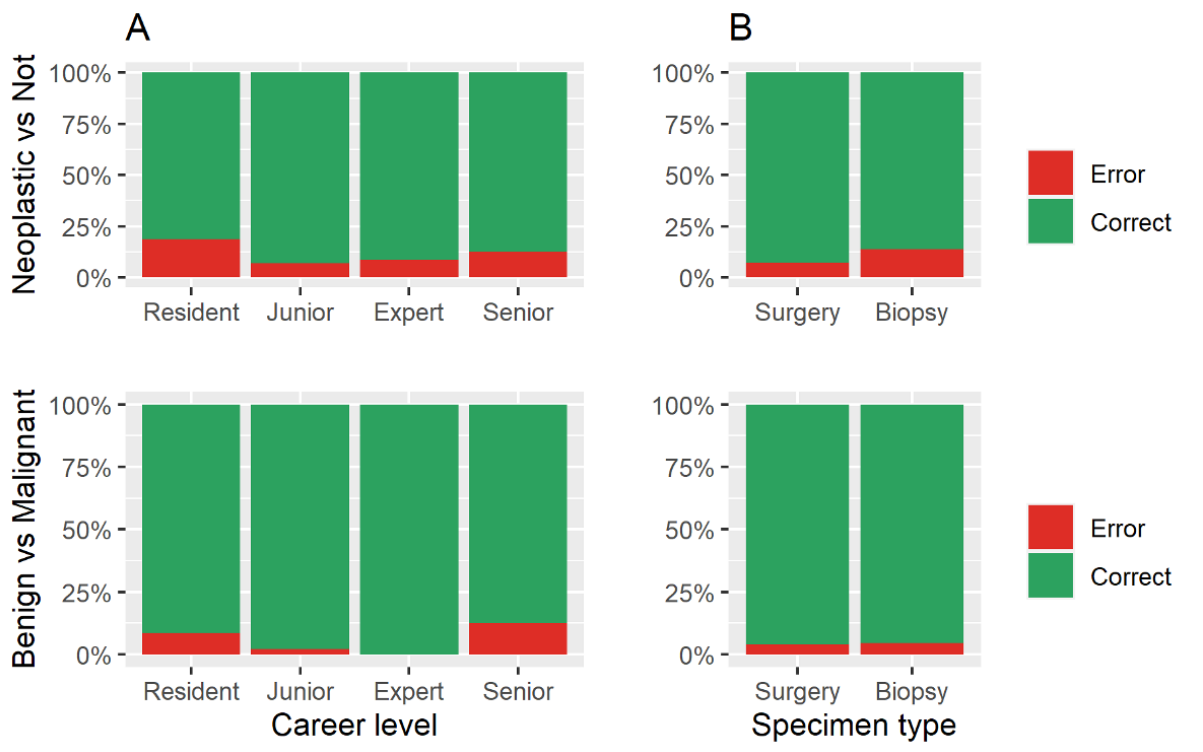
Figure 2. Raw proportion of errors across (A) career levels and (B) specimen types in performing two important tasks: differentiation between neoplastic and nonneoplastic processes and between malignant and benign